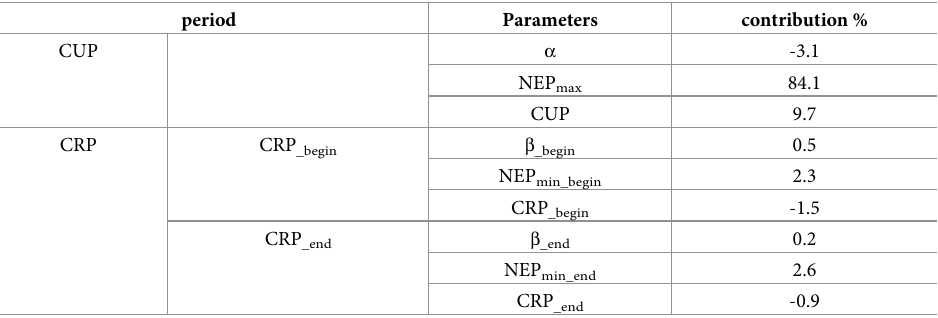
Table 1. Relative contributions of the ratio of actual carbon dioxide uptake to hypothetical maximum carbon dioxide uptake ( α ), the maximum daily net ecosystem production (NEP max ), the net carbon dioxide uptake